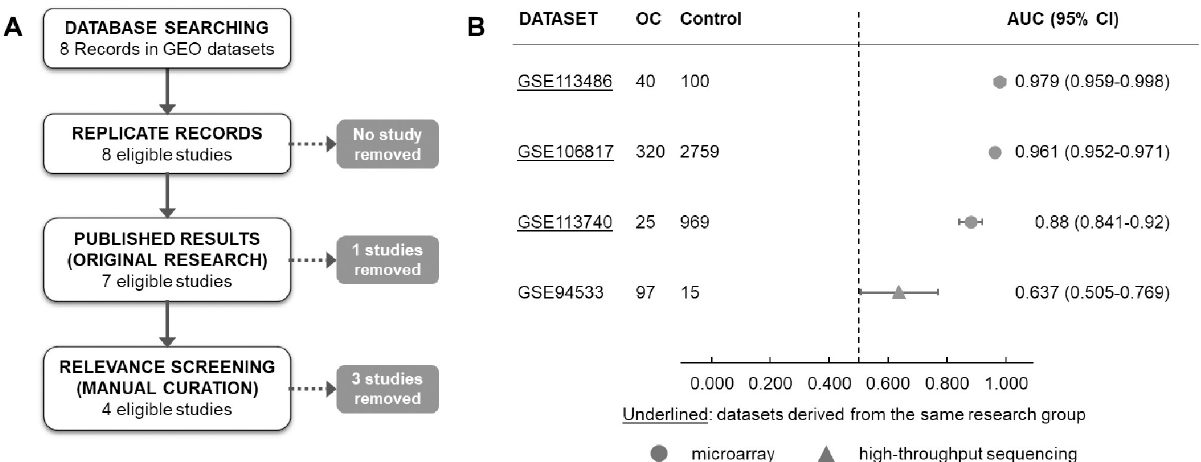
Fig 4. Performance of the circulating miRNA model in the publicly available datasets. A. Screening of appropriate datasets to be used in the cross- study validation step. Among eight studies found in the GEO datasets, four were eligible to test the 2-miRNA diagnostic model. B. The forest plot shows the AUCs and 95% confidence interval (CI) obtained for each study, all of them presenting the lower bound higher than 0.5.